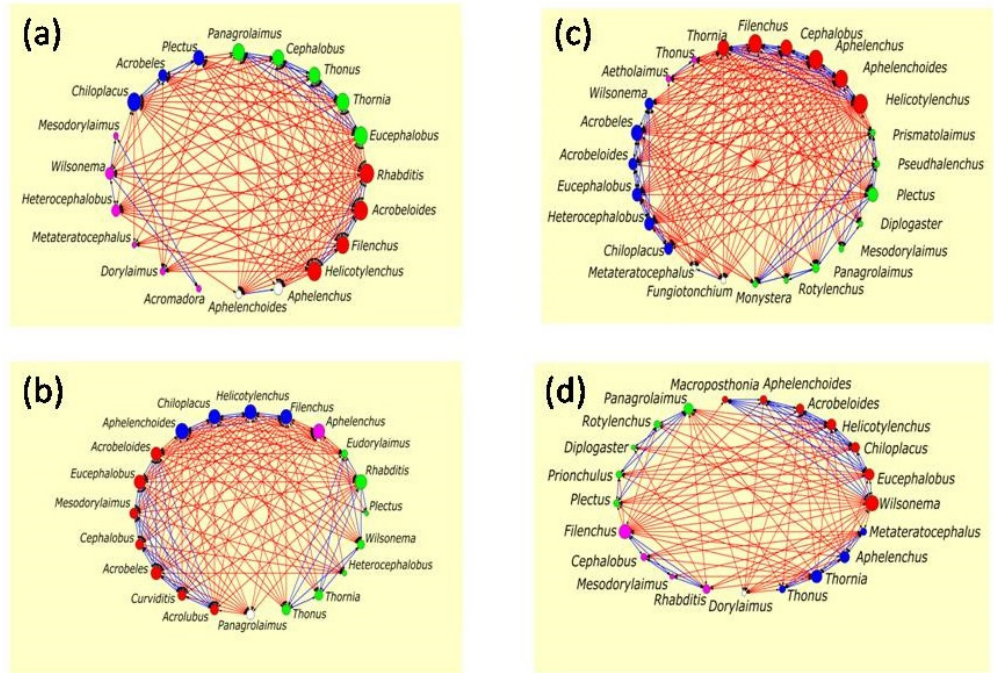
Figure 5. ( a – d ) Networks of relationships among the nematode genera in the reclaimed landfill sections: ( a ) R3, ( b ) R10, ( c ) R14 and ( d ) reference sites (Ref). Nodes were ordered by the class of structural equivalence and plotted in a circular format. Different colors correspond to different classes of structural equivalence, while the size of each node represents its out-centrality. Red-colored lines represent links between classes of structural equivalence, while blue-colored lines correspond to links within classes of structural